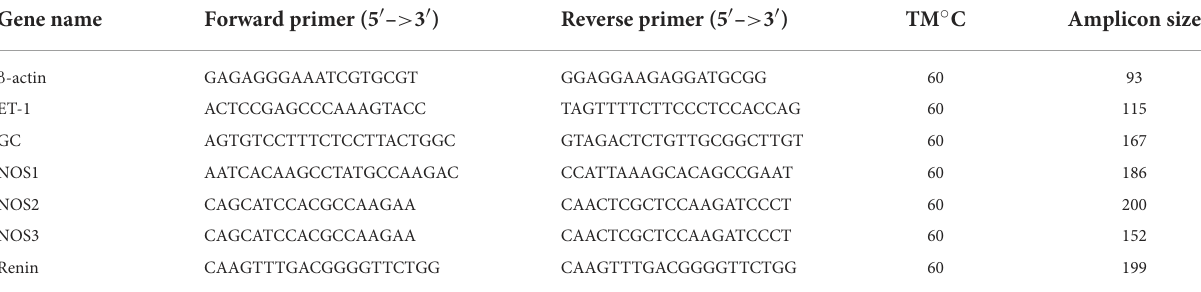
TABLE 2 Primers used for real-time